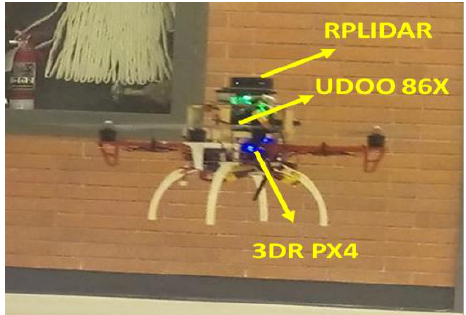
Figure 4. Quadcopter fully assembled with LIDAR, autopilot, and embedded